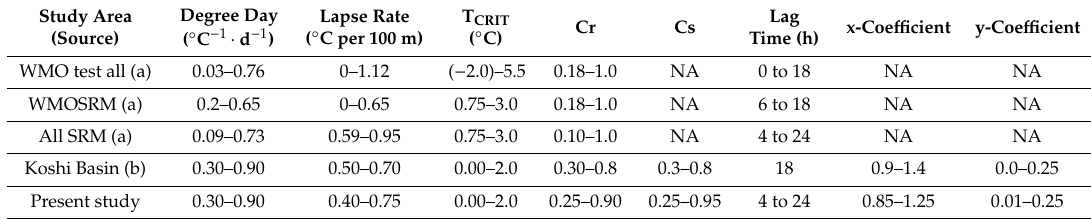
Table 1. Parameter Values Range Used for the Snowmelt Runo ff Model